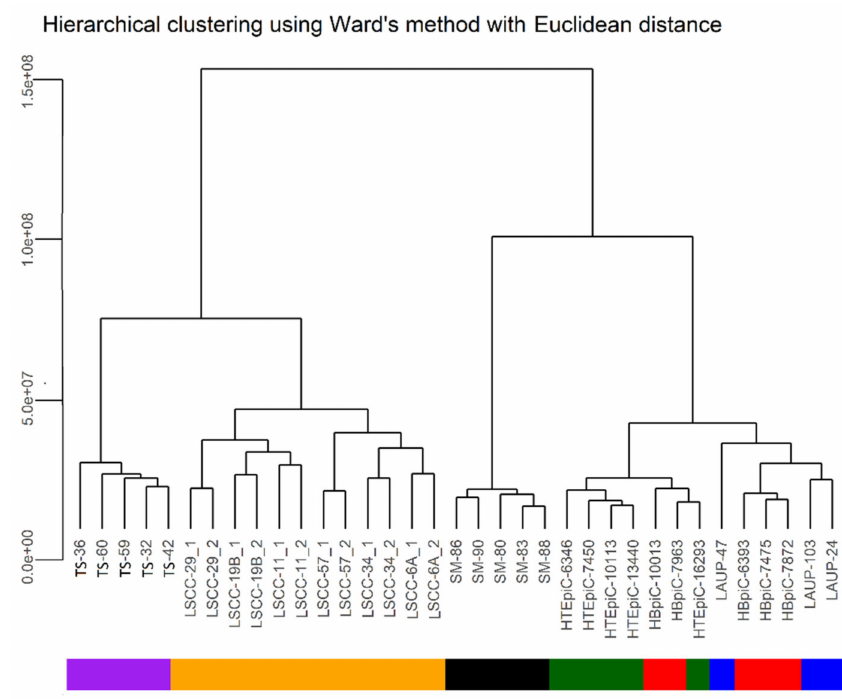
Figure 3. Hierarchical clustering of the studied cohorts using Ward’s